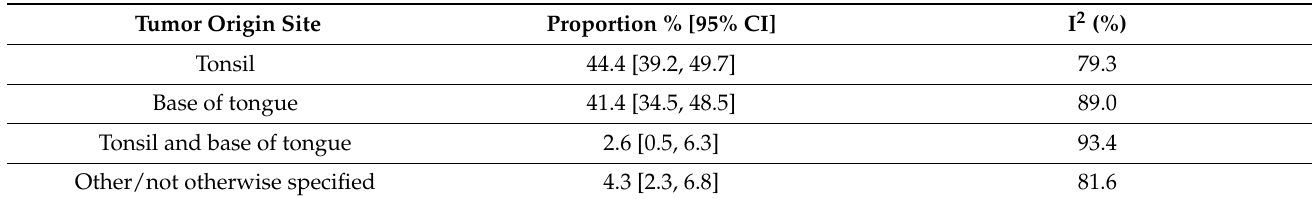
Table 4. Meta-analysis of tumor origin site and I 2 values amongst 21 studies ( n =